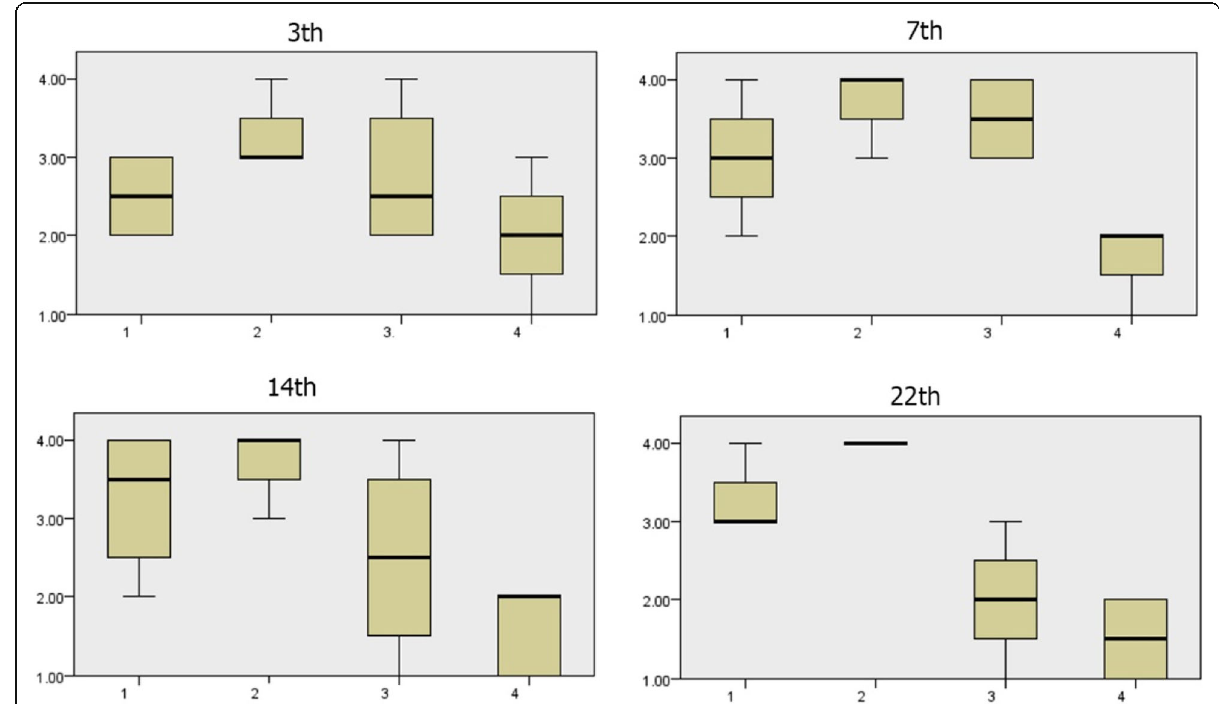
Fig. 3. Granulation scores during the 3rd, 7th, 14th, and 22nd days. There is a significant difference in the amount of wound granulation during the 7th and 14th days between the control and treatment groups. The amount of wound granulation formation in the Satureja khuzistanica -treated group was more than that in the other treated groups and control group on the 14th day. (1) Control group, (2) Satureja khuzistanica -treated group, (3) alginate hydrogel dressing-treated group, and (4) alginate hydrogel/ Satureja khuzistanica dressing-treated